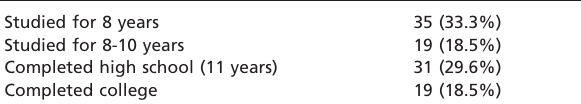
Table 1 - Education levels among the patients with chronic back pain. Studied for 8 years